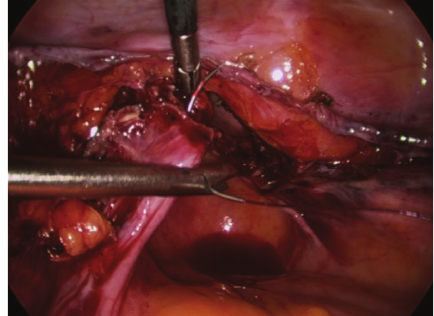
Figure 1: Suture is passed through the USL from about 1.5 cm posterior to the cut edge, exiting the USL fibers just proximal to the pubocervical